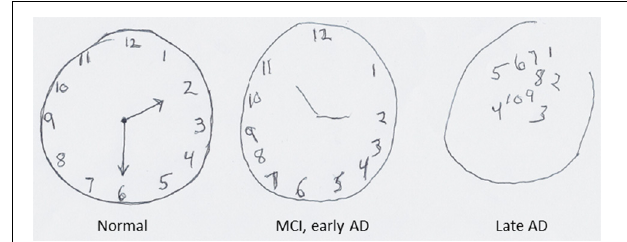
FIGURE 4 | The progressive deterioration of pattern processing ability in a subject as they progress from mild cognitive impairment (MCI) to severe Alzheimer’s disease (AD). In this clock drawing task the subject is asked to draw a clock with the hours and showing the time 2:30. When the person has MCI/early AD the numbers for the hours on the clock are drawn in proper order, but during the time it took to draw the clock the subject forgot that he/she had been asked to show the time 2:30. In the case of the patient with late-stage AD, the drawing bears little resemblance to a